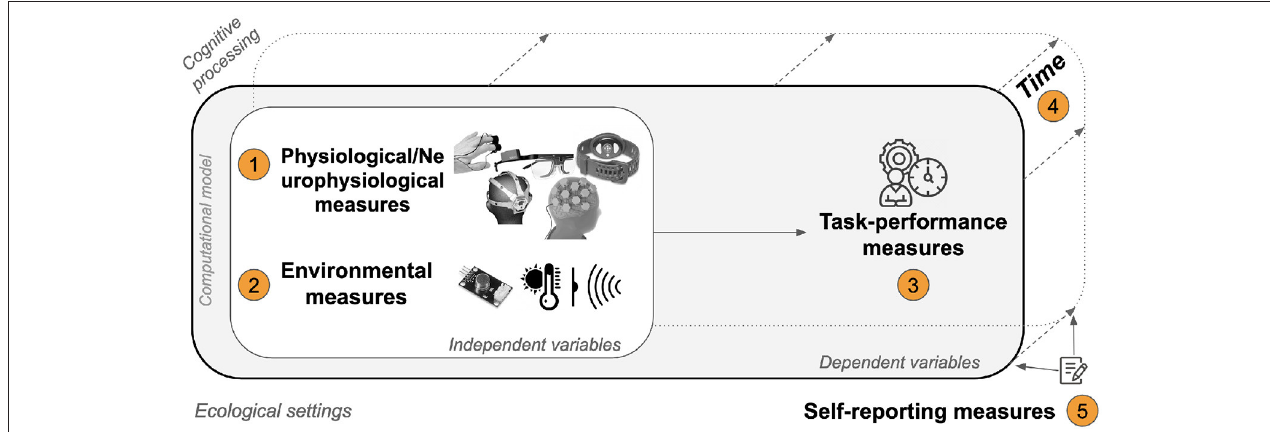
FIGURE 16 | An envisioned framework toward the development of a robust multidimensional mental workload model with high reliability, sensitivity, diagnosticity and validity, with different classes of measures and